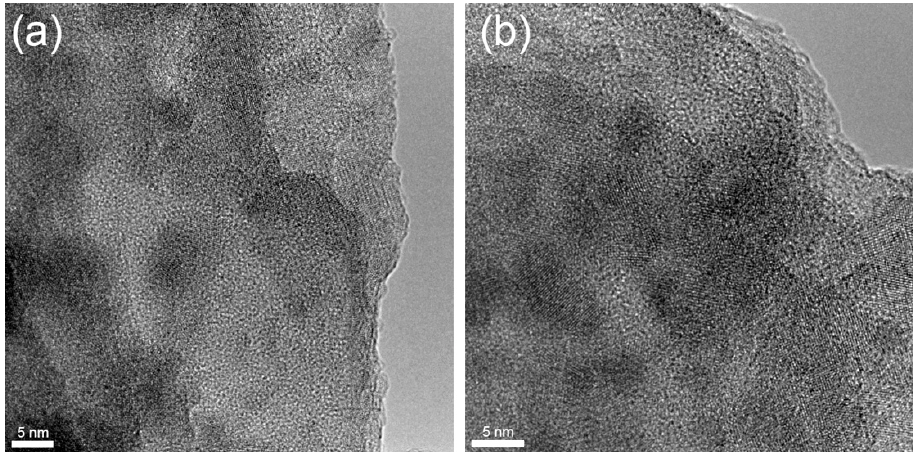
Figure 4. ( a , b ) HRTEM images of zone A in di ff erent areas.